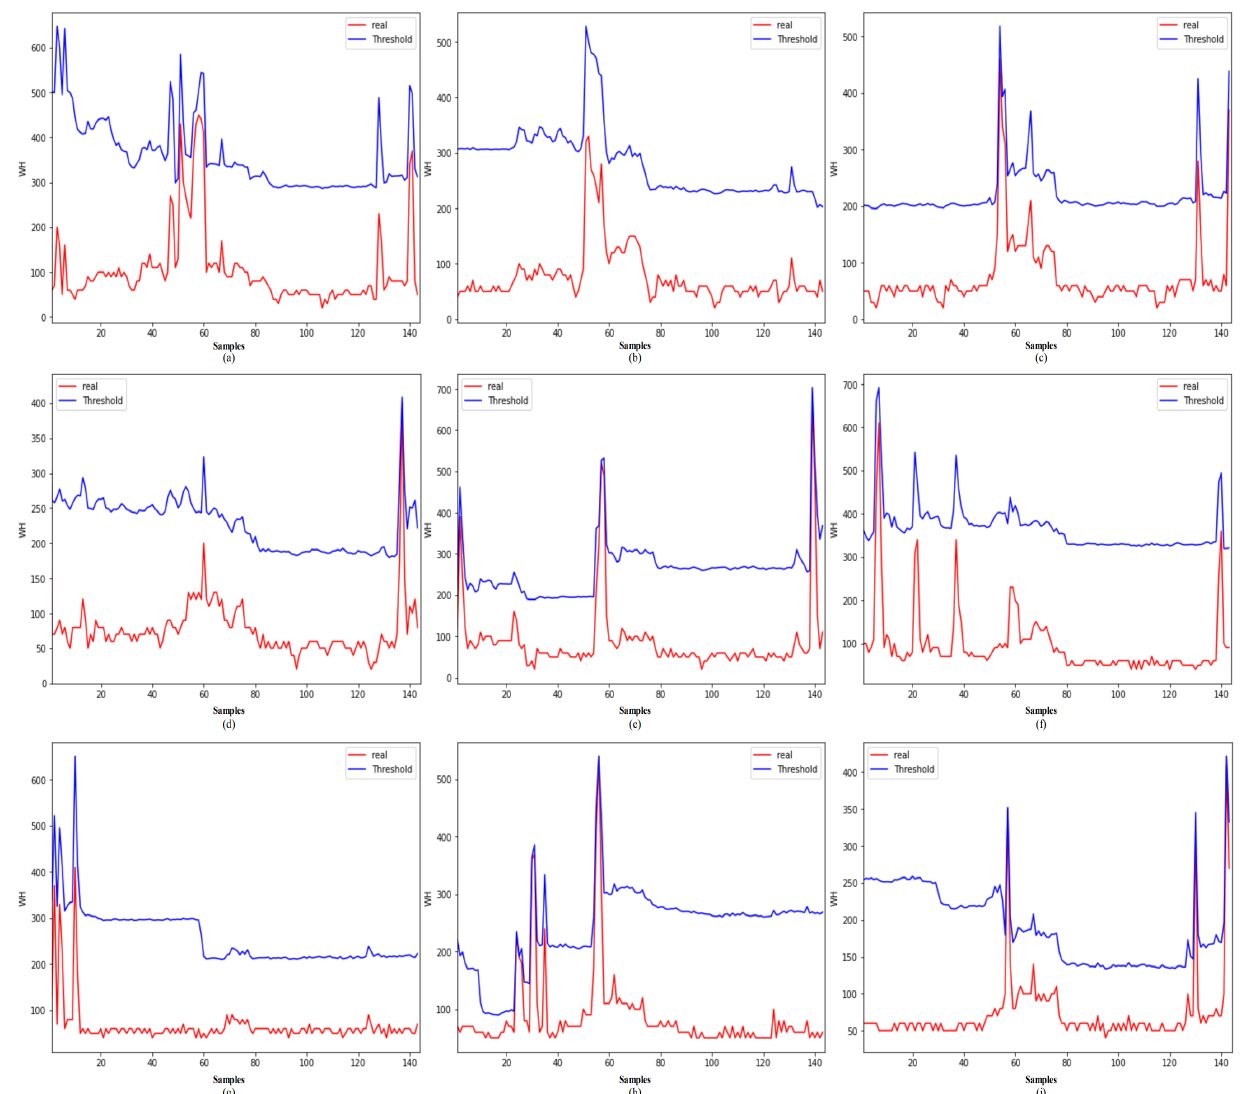
Figure 3. Example of the first group of normal energy consumption behavior: ( a ) electricity con- sumption on 1 May; ( b ) electricity consumption on 2 May; ( c ) electricity consumption on 3 May; ( d ) electricity consumption on 4 May; ( e ) electricity consumption on 5 May; ( f ) electricity consumption on 6 May; ( g ) electricity consumption on 8 May; ( h ) electricity consumption on 9 May; ( i ) electricity consumption on 10